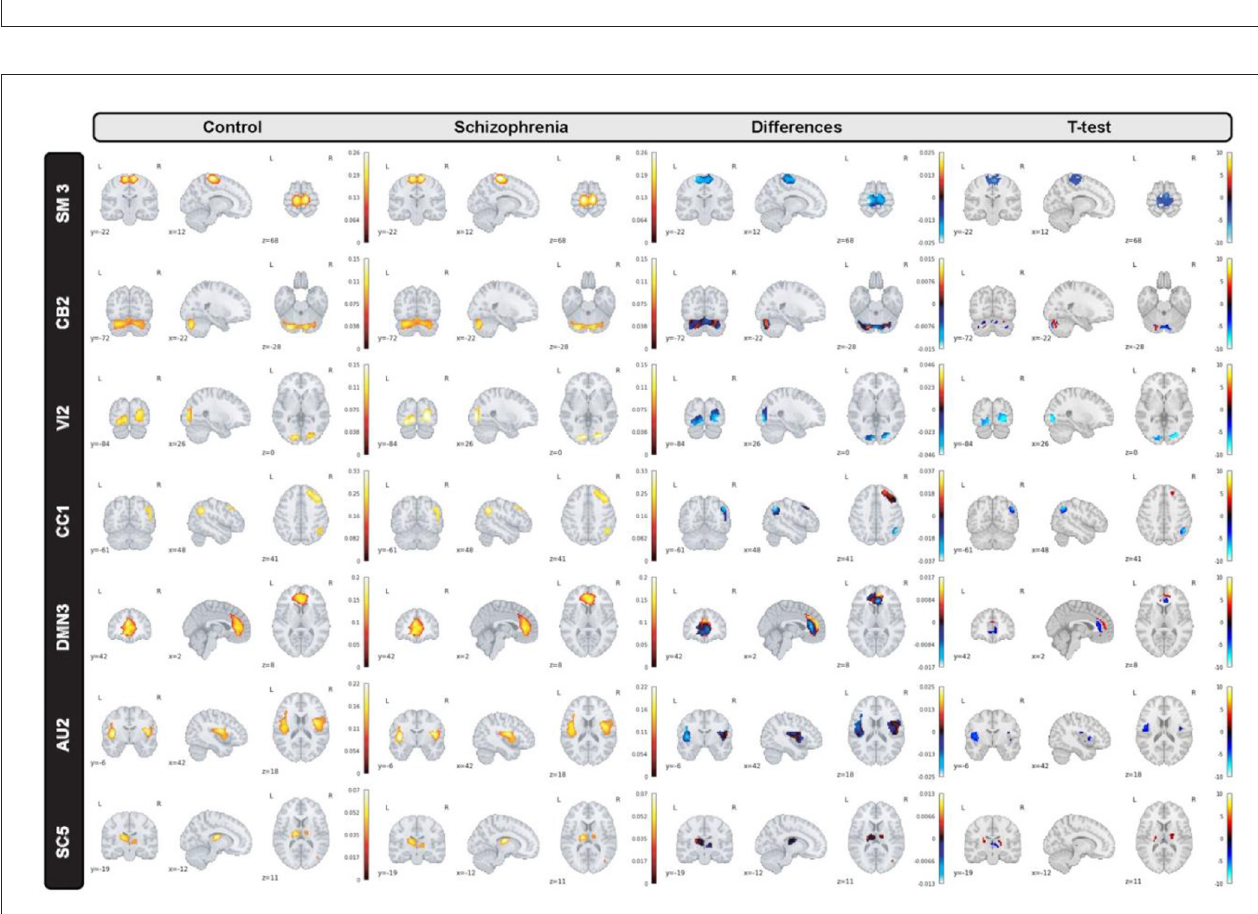
FIGURE4 A subset of group level spatial maps averaged over time and subject for each control and schizophrenia patient along with subtracted maps and 2 sample T -tests to illustrate group level dissimilarities in sensori-motor (SM3), cerebellar (CB2), visual (VI2), cognitive control (CC1), default mode network (DMN3), auditory (AU2), and subcortical (SC5) networks. Furthermore, all brain maps are masked to focus on region of interest (ROI).